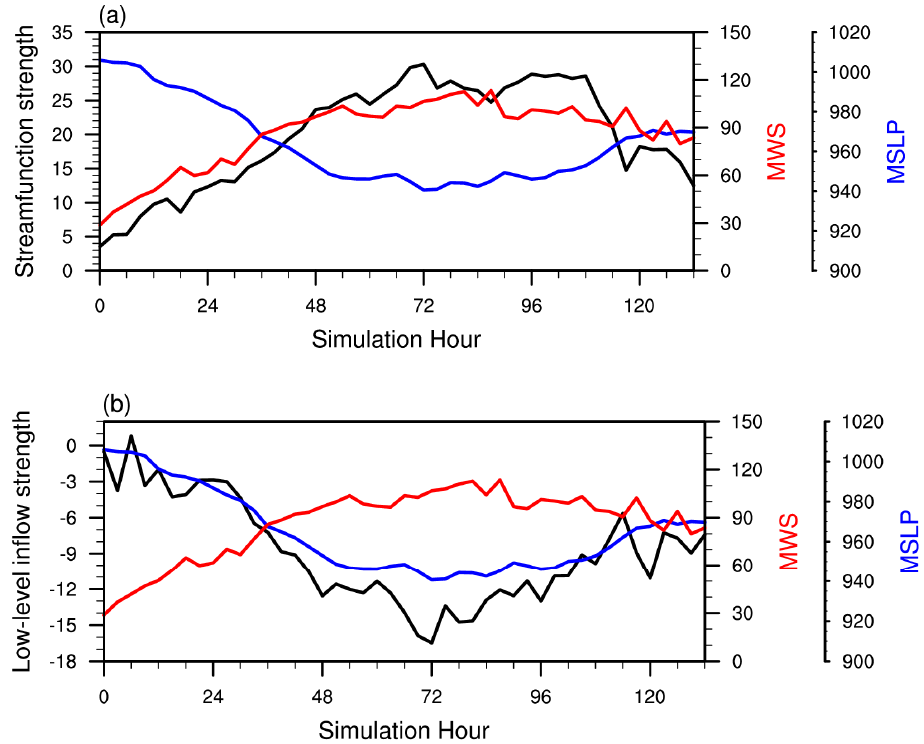
Figure 6. Temporal evolutions of ( a ) the secondary-circulation stream function index (black; 10 9 s − 1 ), ( b ) the secondary-circulation low-level inflow index (black; m s − 1 , negative represents inflow), the MWS (red; knots), and the MSLP (blue; hPa).